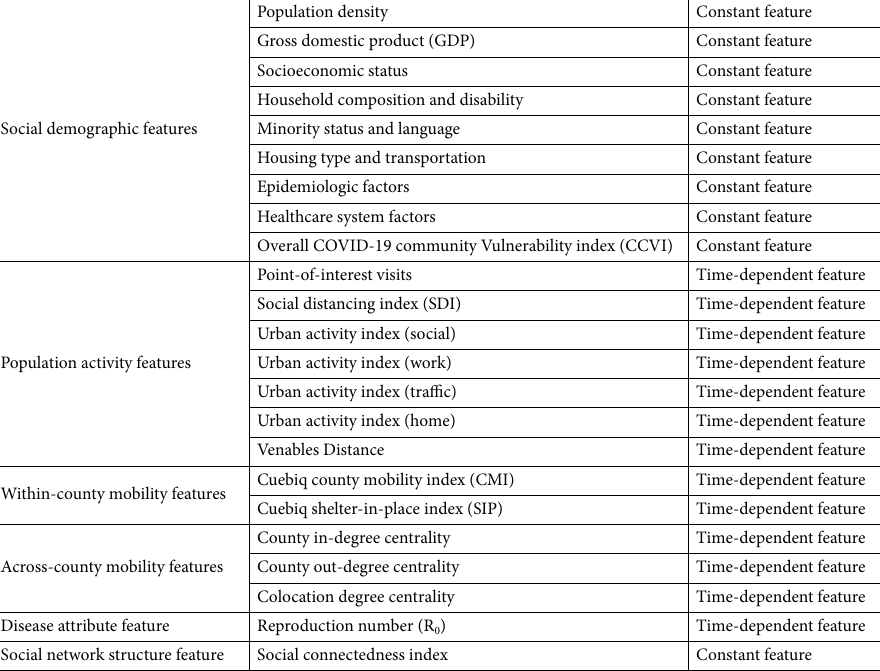
Table 1. Collected features for the data-driven model.